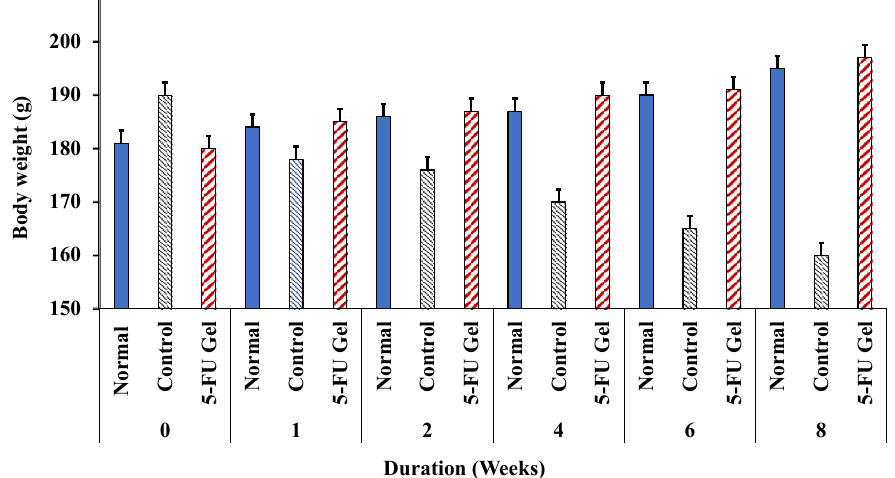
Figure 6. The relative body weight changes of normal rats (have no tumor), control rats (untreated tumor-bearing rats) and rats treated with 5-FU loaded Cs/ β -GP + PL gel. The results are presented as the mean ± SD ( n = 8).